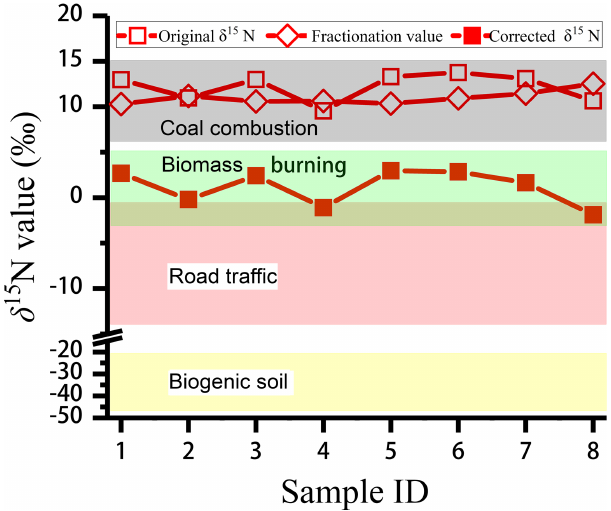
Figure 3. Original δ 15 N values ( δ 15 N ini ) for p NO − values for the N isotope fractionation ( ε N ) associated with the conversion of gaseous NO x to p NO − ( δ 15 N corr ; 15 N ini minus ε N ) of p NO − during the Sanjiang sampling campaign. The colored bands repre- sent the variation range of δ 15 N values for different NO x sources based on reports from the literature (Table S2). See Table S3 for the information regarding sample